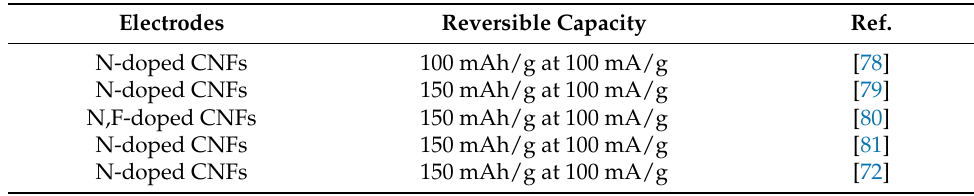
Table 3. Comparison of the performance of the SIBs based on CNF electrodes.